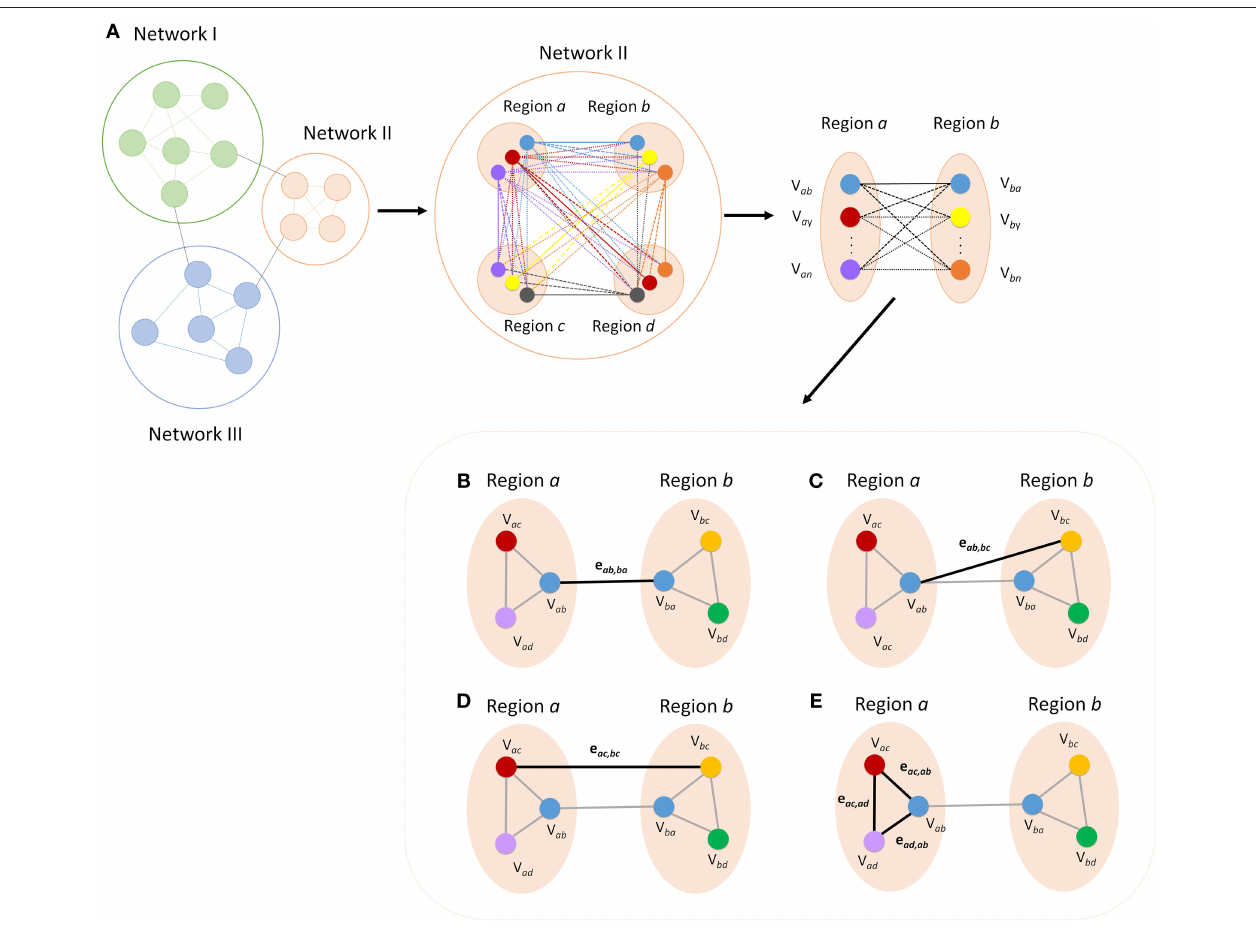
FIGURE 2 | Breakdown of regional areas from major networks allows for the calculation of connectivity between specific nodes within each network. The figure shows a representation of how more detailed measures of functional connectivity can be derived (A) . All connections within a given network can be broken down and defined according to how each node was defined. Functional definition allows for labeling of each ROI and edge for categorization into specific types of nodes and connections. Primary connectivity (R 1 ) is the connection between the two nodes that were defined by maximum connectivity between the opposite region (B) . A primary to secondary connection (R 12 ) is the connectivity between a primary node and a node that is a primary node to another region (C) . Secondary connections (R 2 ) are the connections between secondary nodes in the two regions (D) and intra-regional connections (R I ) are the connections between the nodes in a given region (E) .